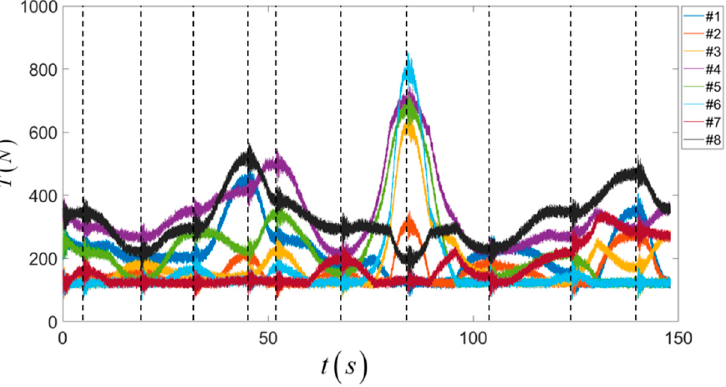
Figure 24. Diagram of the control system of our proposed prototype.